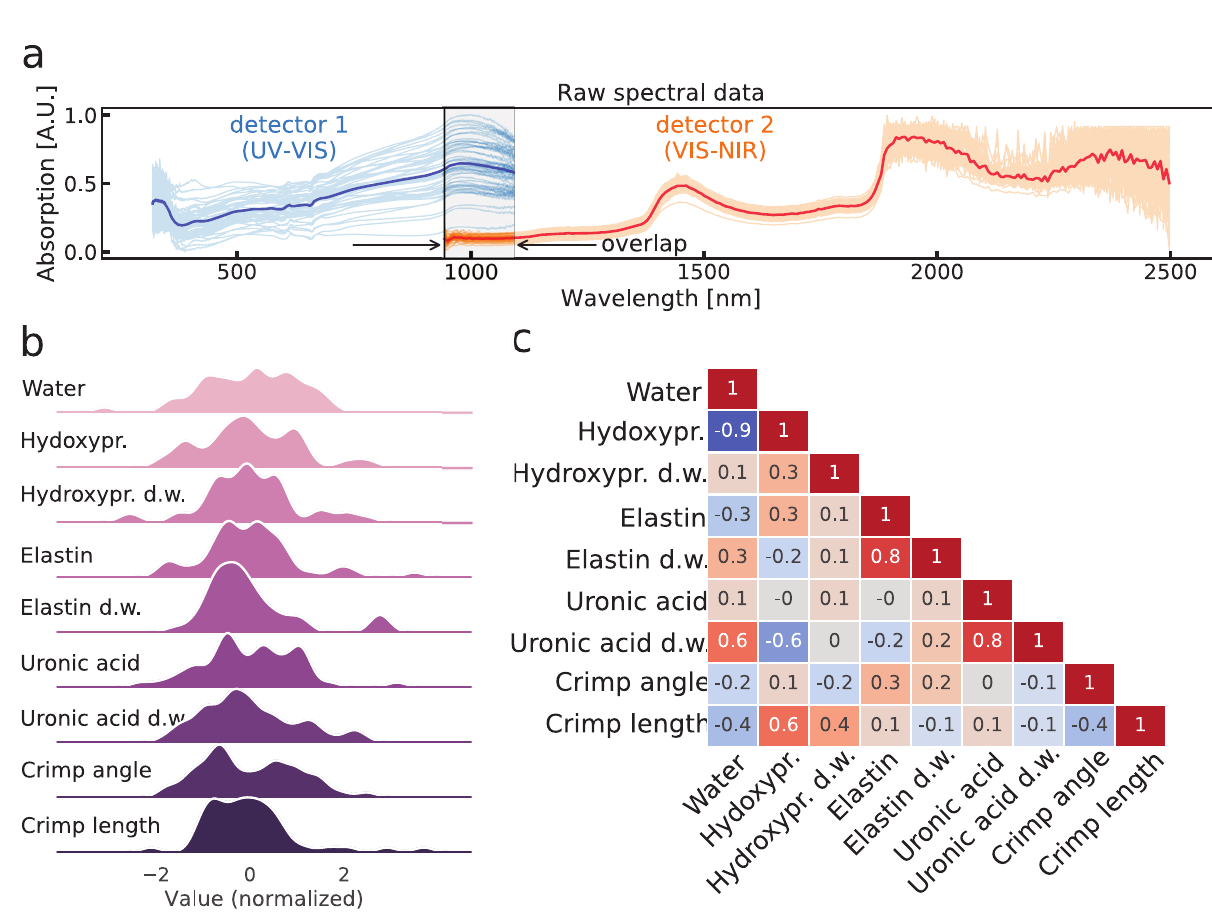
Fig 3. NIRS measurements and reference variables. a : Full wavelength range of the collected NIR spectra from detector 1 (blue) and detector 2 (orange). Thick lines represent the average spectra. Absorption values from both detectors have been rescaled to range from 1 to 0 to enable easier comparison. b : Normalized distribution of the reference properties. c : Correlation between the reference properties. Color of the boxes represents the sign and strength of the correlation.